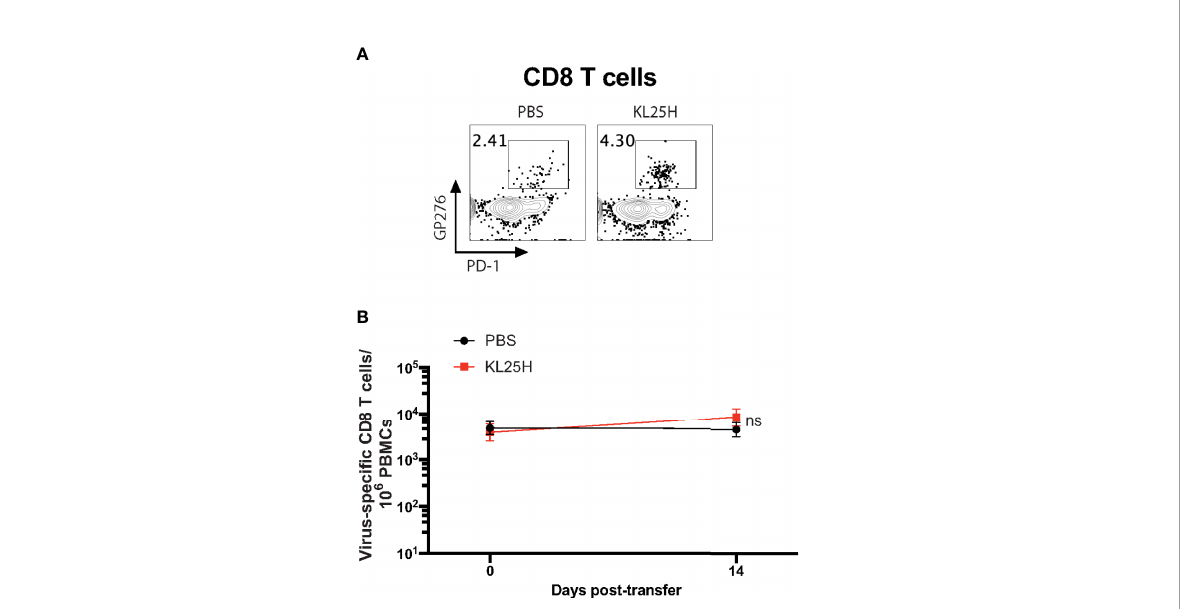
FIGURE 3 CD8 T cell responses are not signi fi cantly improved by adoptive B cell therapy. (A) Representative FACS plots showing the frequencies of LCMV-speci fi c CD8 T cells in PBMCs at day 14 post-transfer. (B) Summary of LCMV-speci fi c (GP276-speci fi c) CD8 T cells. Experiments were performed 3 times, n=3-5 mice per experiment. Error bars represent SEM. The p-values were calculated using Mann-Whitney test. ns, not signi fi cant.